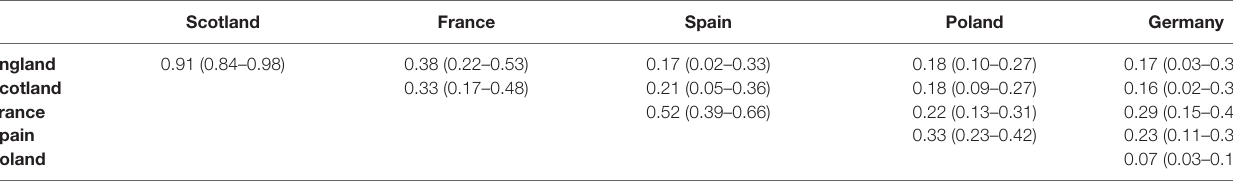
TABLE 3 | Agreement in reimbursement status between countries for all analyzed drugs.